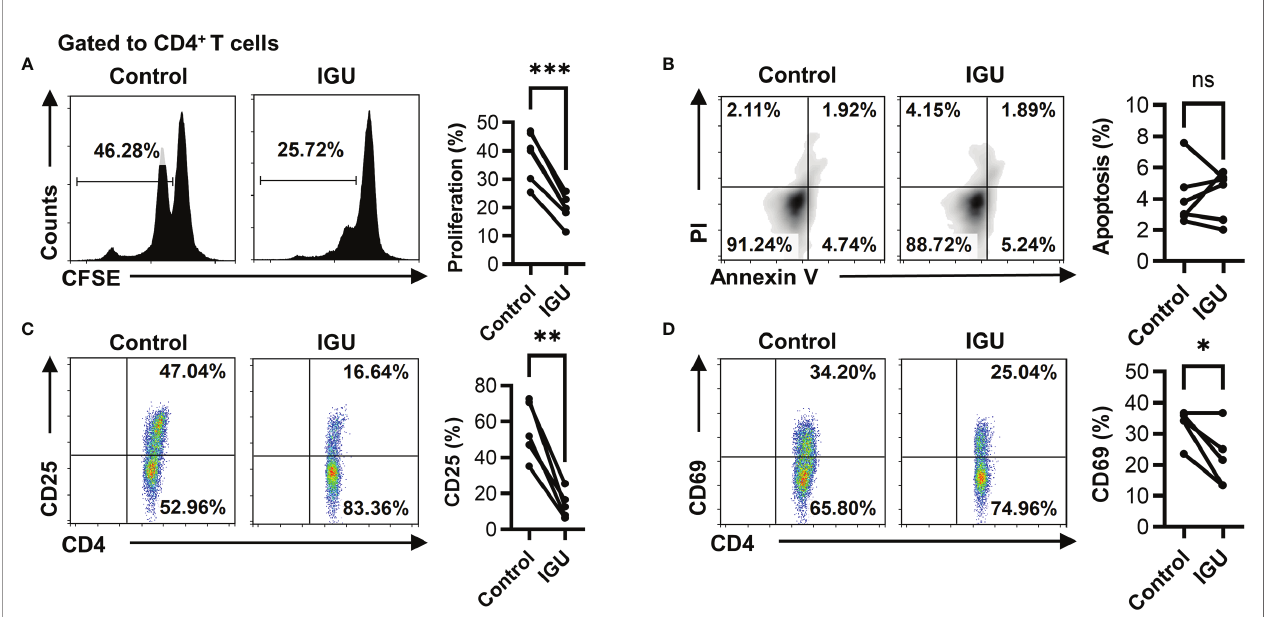
FIGURE 2 | IGU inhibits RA-CD4 + T cell proliferation and activation. The PBMCs from RA patients were cultured in the presence of anti-CD3/CD28 antibody (2 m g/ ml) in the presence of vehicle (DMSO) or IGU for 5 days. (A) The proliferation of RA-CD4 + T cells was detected by the CFSE labeling method (n = 6). (B) The apoptosis of RA-CD4 + T cells was detected after being cultured for 24 hours (n = 6). Propidium iodide (PI) and Annexin V (AV) staining were determined by fl ow cytometry. The data of early apoptotic cells (PI − AV + ) were shown. (C, D) RA-PBMCs were cultured in the presence or absence of IGU for 72 hours. Flow cytometry detected the expression of activation markers (CD25 and CD69) on CD4 + T cells (n = 5). Symbols represent individual subjects. ns, no signi fi cance; * P < 0.05; ** P < 0.01; *** P <